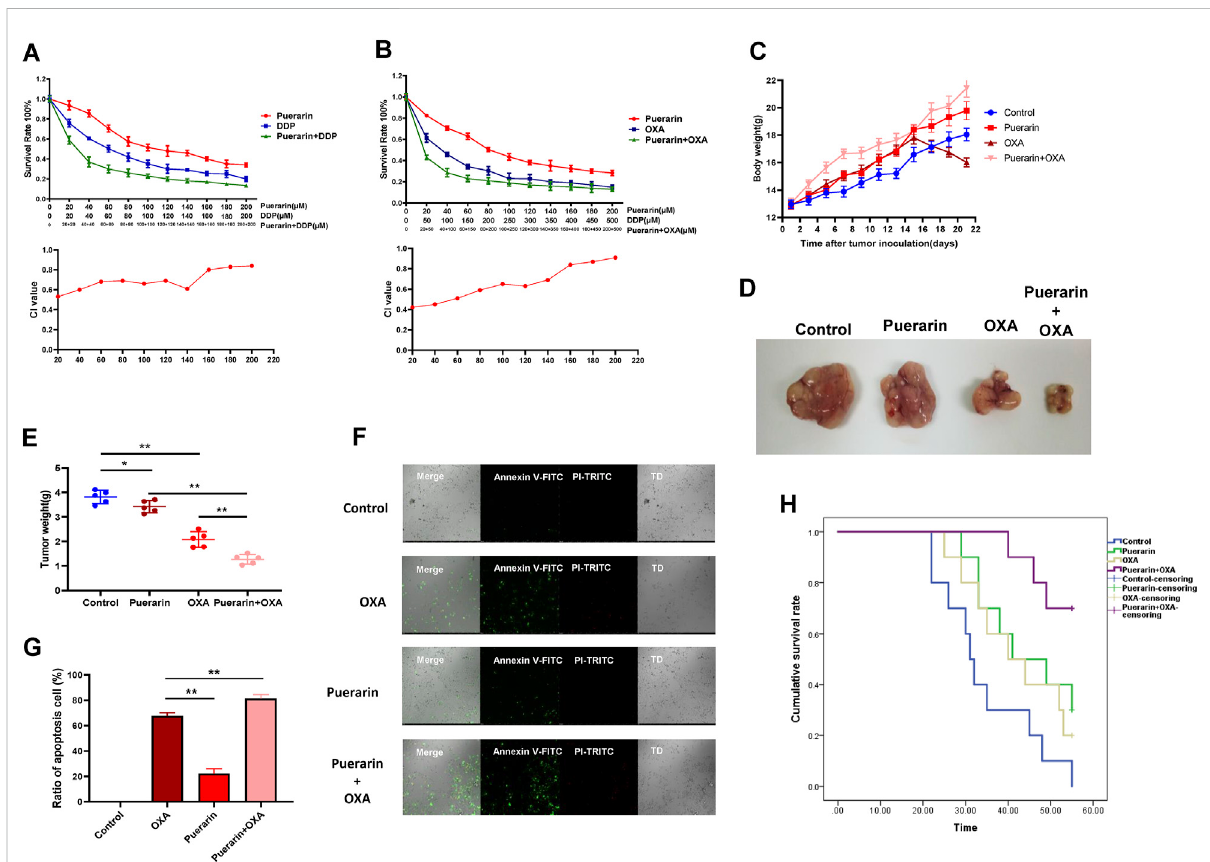
Puerarin enhanced the effects of OXA. (A,B) MTT assay was operated to detect the inhibition on MCF-7 cells. Puerarin enhances the inhibitory effect of OXA and DDP on cell proliferation (C – E) Mice in the combination treatment group gained weight compared to those in the OXA-treated group.Comparedtotheothergroups,thetumorweightofco-treatmentgroupislowest. (F,G) AnnexinV-FITCandPI-TRITC wereusedtodetected the apoptosis cells. Puerarin improves the ef fi cacy of OXA and a signi fi cant increase in apoptosis cells was observed in the co-treatment group (H) Mice of co-treatment group had a higher survival rate than the mice in other groups (* p < 0.05, ** p <